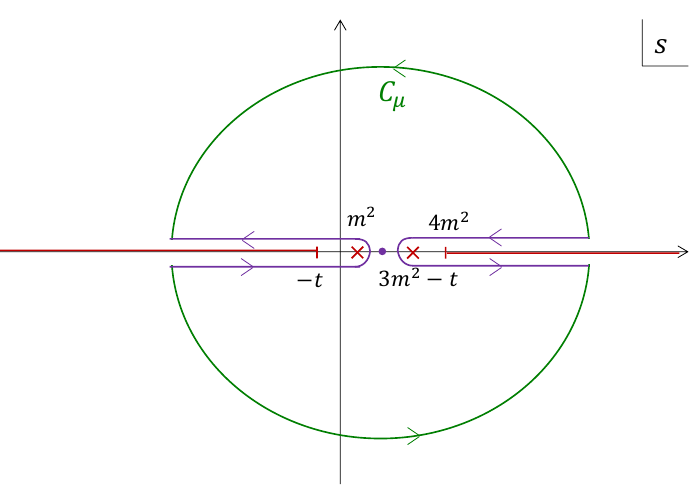
Figure 1 . The circular contour C µ used to define